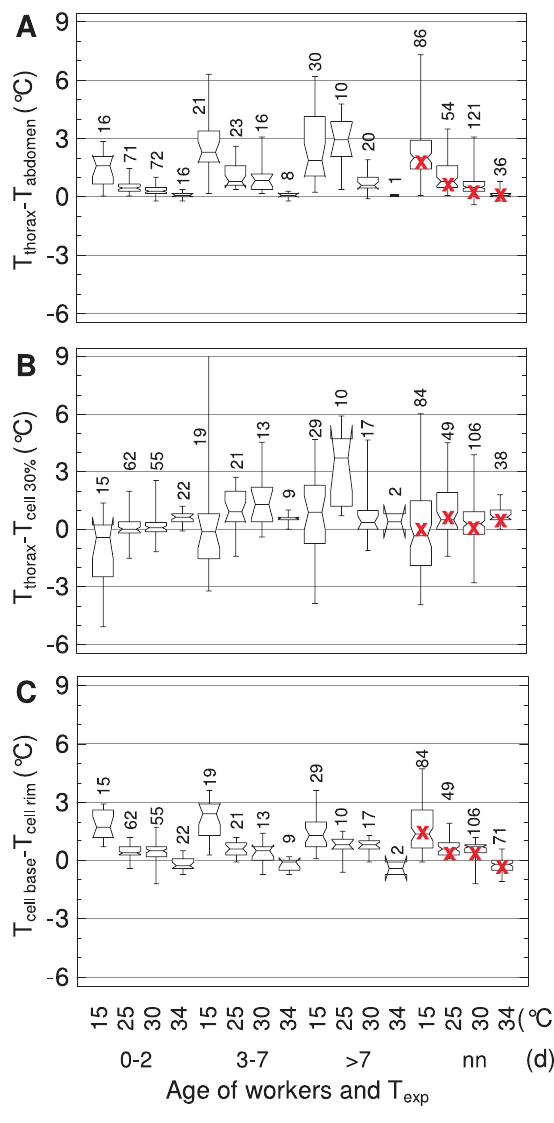
Figure 7. Thermal relations in open brood nest cells visited by bees. Box plots: median with 1 st and 3 rd quartile, maximum and minimum. Notches which do not overlap indicate significant differences (P , 0.05). nn = unmarked workers; red crosses = medians of all age groups of marked bees (not significantly different from nn bees, except T thorax -T abdomen at T exp =25 and 30 u C, P , 0.05, U test).T cell 30% is the cell wall temperature at the estimated mean contact position of the thorax with the cell wall at 30% cell depth as measured from the base, calculated by linear interpolation between T cell base and T cell rim . Numbers = measurements (bees). doi:10.1371/journal.pone.0008967.g007 threshold differences between individuals, according to the threshold model of task allocation in polyandrous social insect colonies [e.g. 58]. A higher genetic diversity (with a higher probability of differing thresholds) was reported to improve thermal homeostasis of honeybee colonies [27]. We suggest that individual endothermy is kept up until an individual optimum of local temperature (probably T comb , see below) is achieved. The sum of temporally and spatially distributed individual phases of endothermy enables the superorganism honeybee colony to achieve thermal homeostasis.